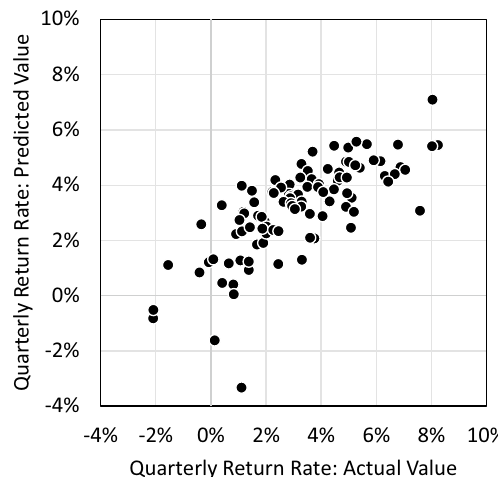
Fig. 36 Actual and predicted values of the quarterly return rate in the t